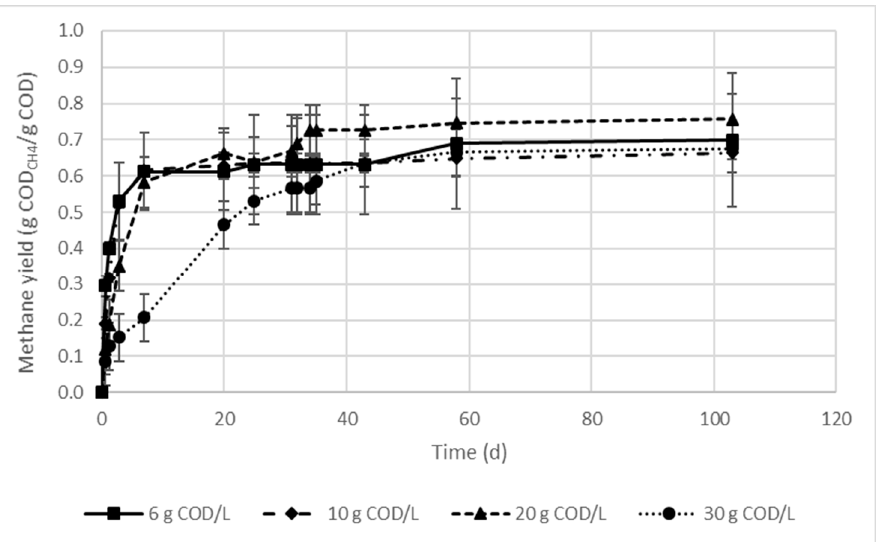
Figure 2. Methane yield of H140 at mesophilic conditions under different organic load (OL). COD = chemical oxygen demand.